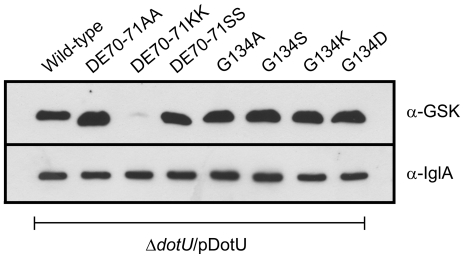
DotU expression in F. tularensis LVS.Analysis of DotU protein synthesis from ΔdotU expressing GSK-tagged DotU or mutated variants thereof in trans. DotU proteins contained in the pellet fraction were separated by SDS-PAGE and identified by immunoblot using an anti-GSK antiserum. Antibodies specific for IglA was used as a loading control. The experiment was repeated two times and a representative example is shown.